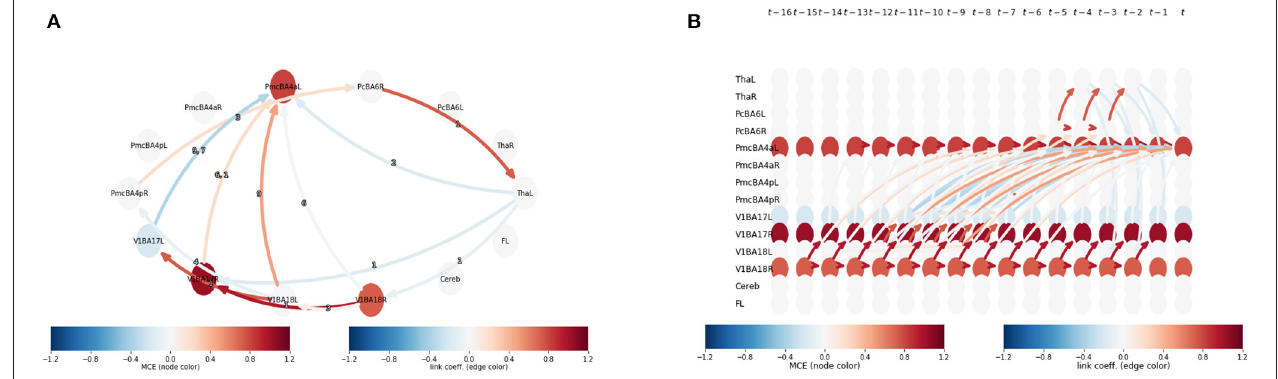
FIGURE 4 | (A) An aggregated graphical model from V1BA18R to PmcBA4aL at lag 15 I CE 12 → 5 (15). It is a summary graph representing the time-series graph in (B) . The edge color shows link coefficient and node color shows the MCE. (B) A time-series-graph of V1BA18R to PmcBA4aL pair at lag 15 I CE 12 → 5 (15) depicts links in relevant causal paths between V1BA18R and PmcBA4aL at lag 15. The edge color shows link coefficient and node color shows the MCE.